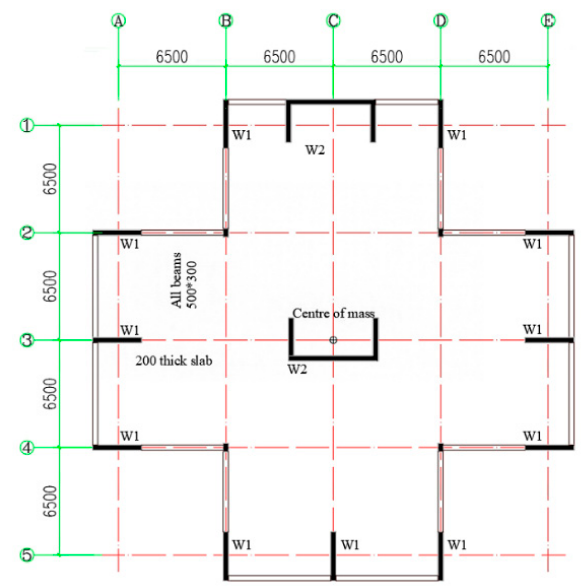
Figure A5. Floor plan of case study building #2.